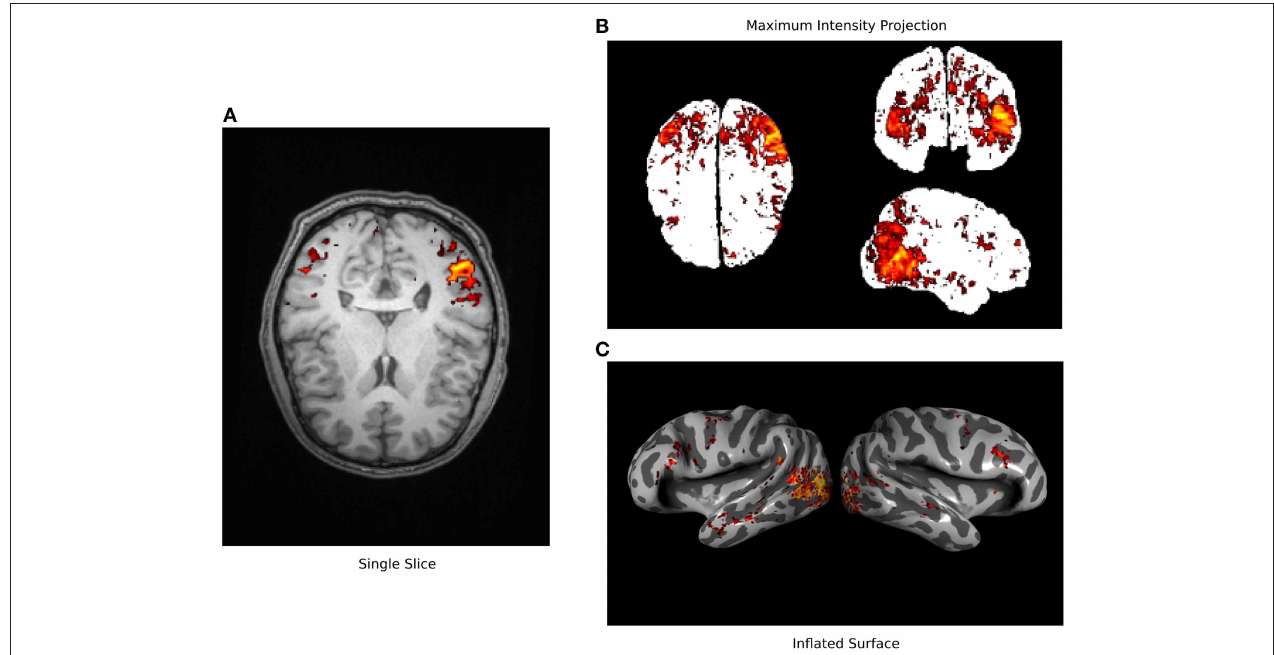
FIGURE 1 | Typical fMRI visualization methods. Three typical methods for visualizing fMRI data are used here to visualize a single data set (Huth et al., 2012). (A) A single axial slice from an anatomical image is shown overlain with functional data exceeding statistical threshold. It is difficult to recognize anatomical features in this view and much of the functional data is hidden. (B) A maximum intensity projection (i.e., a glass brain view) is shown along with all functional data that exceeds a statistical threshold. This view shows more of the functional data than can be seen in the single slice but the anatomical location of these signals is obscured. (C) An inflated cortical surface is shown with curvature highlighted in grayscale, and overlain with functional data exceeding statistical threshold. The anatomical location of the functional data is clearer than in the other views, but multiple views are required to see all of the data. None of these standard visualizations show all of the data in a succinct and interpretable